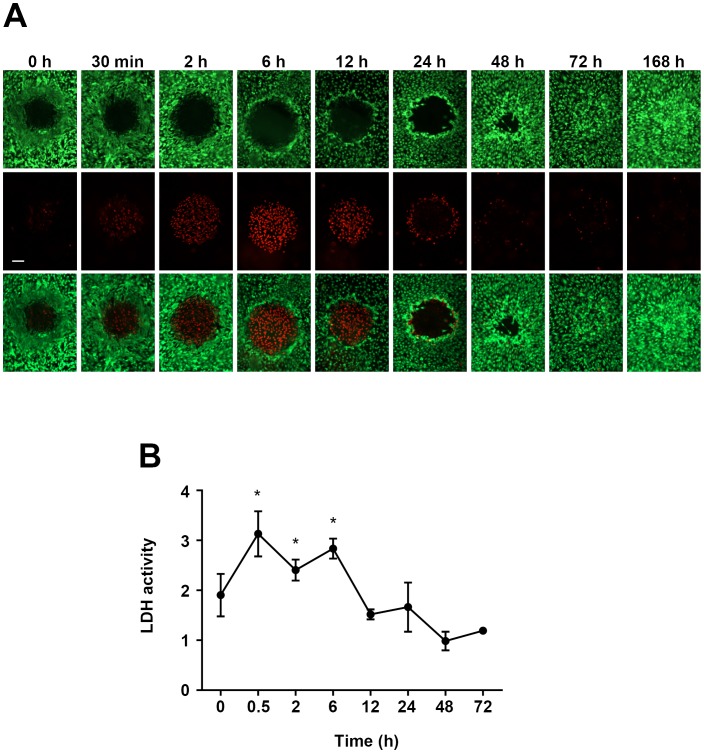
A) Visualization of dead (red) and live (green) ARPE-19 cells after photocoagulation.Loss of plasma membrane integrity results in uptake of red-fluorescent ethidium homodimer-1 in dead cells (middle panels), while living cells stain positive for intracellular esterase activity labelled with green-fluorescent calcein-AM (upper panels). Lower panels show merged images for the two fluorophores. Scale bar represents 100 µm. B) Early transient increase in necrosis in ARPE-19 cells, as assessed by quantification of lactate dehydrogenase activity in the culture medium at various time-points after photocoagulation. Data is expressed as mean absorbance ratio between the photocoagulated samples and the corresponding non-irradiated controls for each time-point. Four samples were analyzed at each time-point; *p<0.05 vs non-irradiated controls at 30 min, 2 h and 6 h.